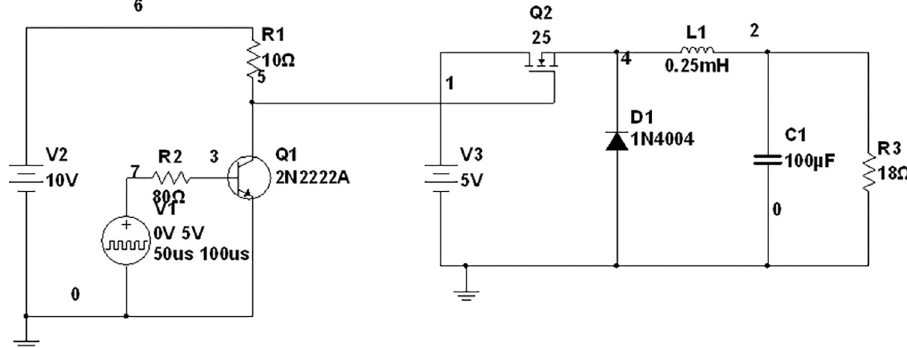
Fig 12. SiC nmos circuit for its transient